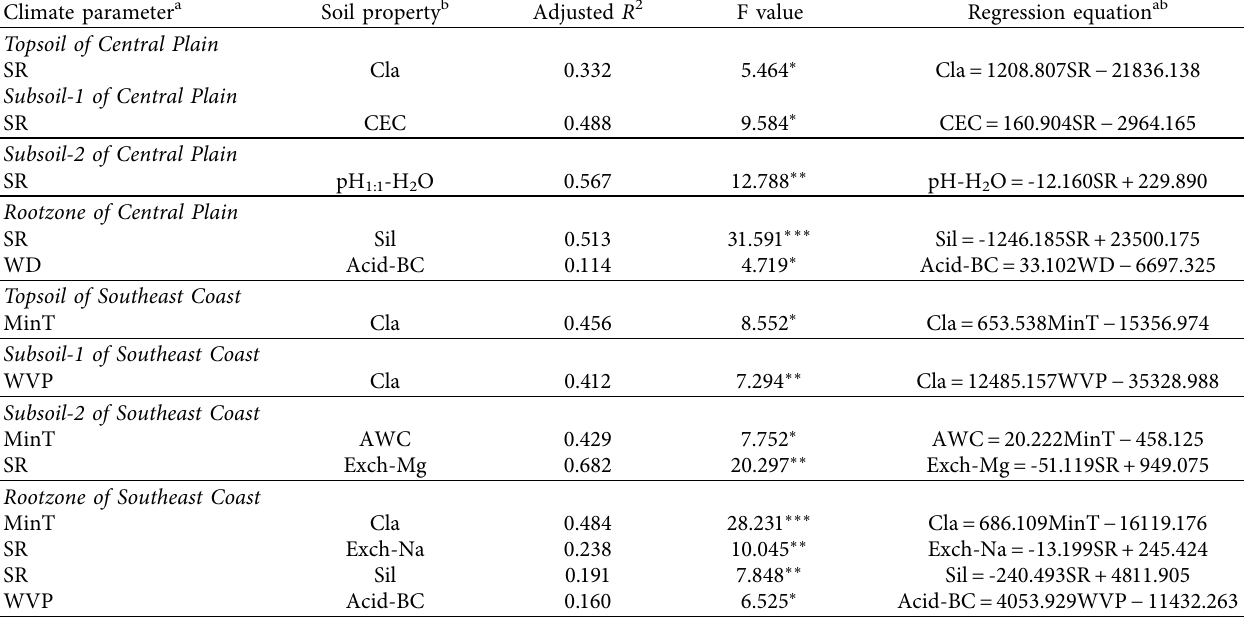
Table 8: Results of stepwise multiple regression analysis on climate and soil variables.